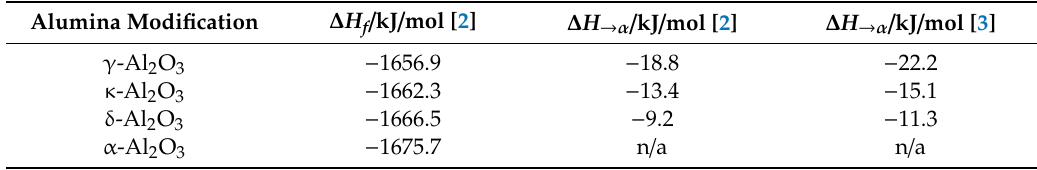
Table 1. Enthalpy of formation ( ∆ H f ) and enthalpy of transition to α -Al 2 O 3 ( ∆ H → α ), for di ff erent cubic alumina modification, as compiled from